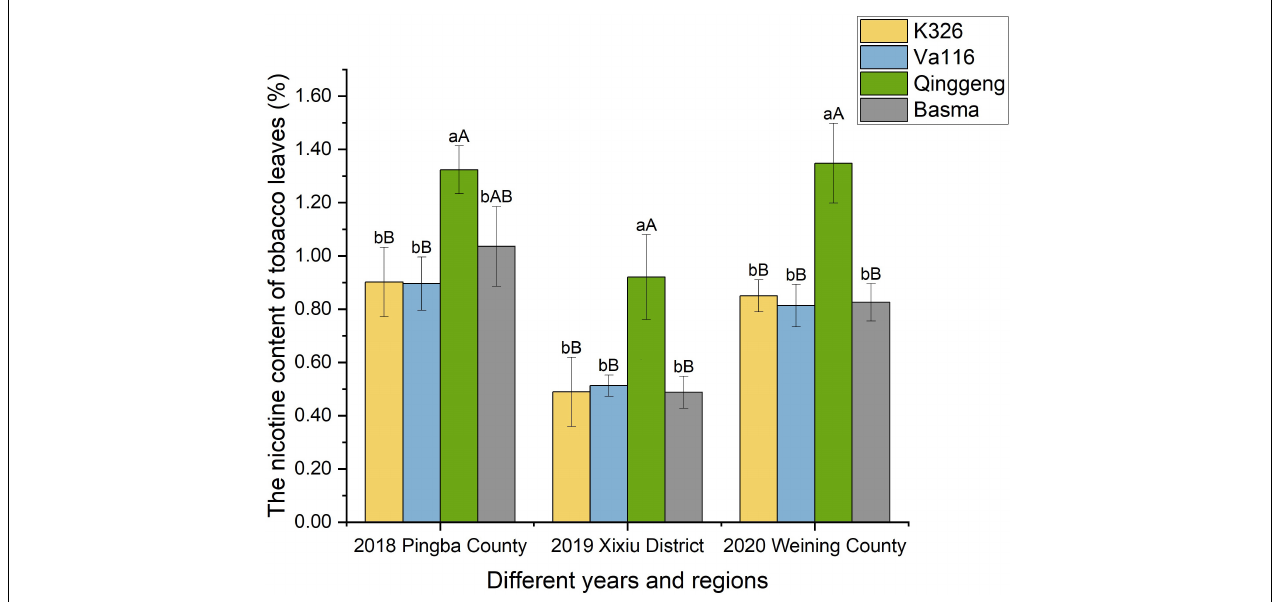
FIGURE 1 | The difference in the nicotine content among four tobacco varieties from different regions (Pingba County, Xixiu District, and Weining County) and years (2018, 2019, and 2020). The average of three biological replicates per material was used for mapping. Error bars represent significant difference of three replicates. Significant differences among the nicotine contents at P < 0.05 and P < 0.01 were determined using the Duncan’s new multiple range test. The lowercase alphabets represent a significant difference ( P < 0.05); uppercase alphabets represent an extremely significant difference ( P <